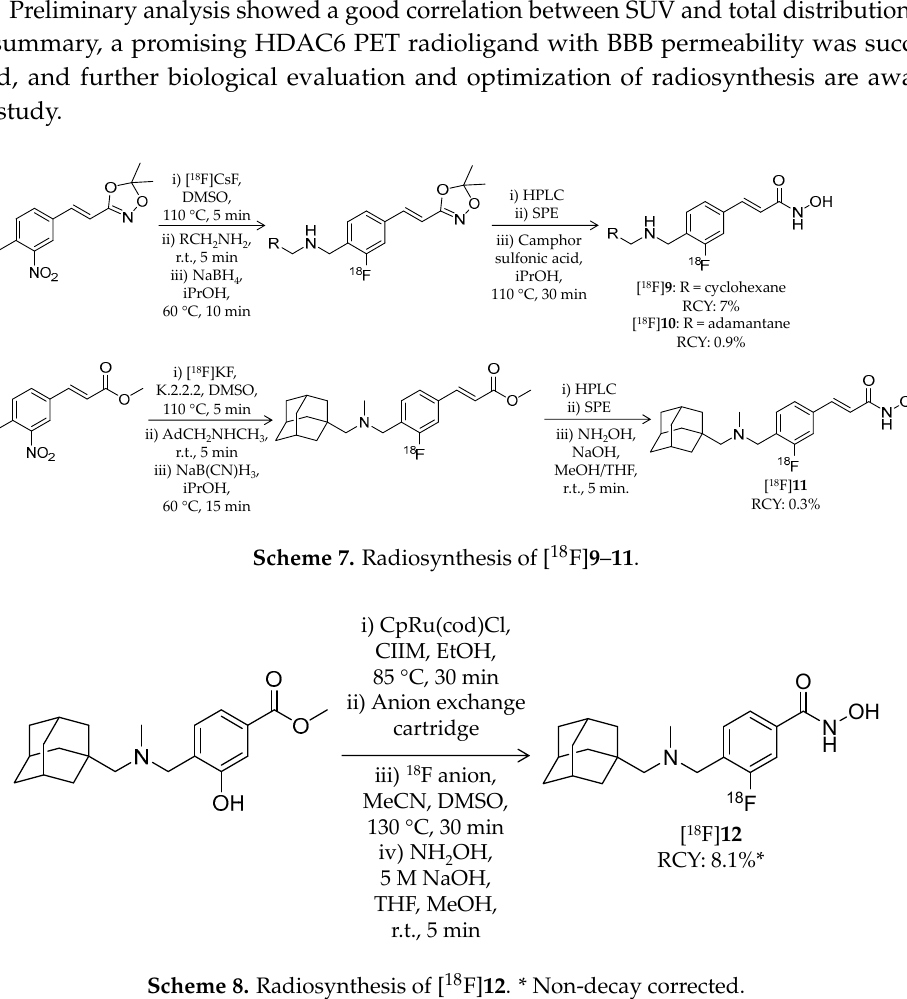
Figure 3. The total volume of distribution ( V T ) images from [ 11 C] 8 PET in baboon brains. Robust brain uptake ( top ) of [ 11 C] 8 was decreased by pre-treatment with unlabeled 8 ( bottom ). (Reproduced from Wang et al. J Med Chem; published by The American Chemical Society, 2014 [68]). HPLC purification gave the desired product in 0.3% decay-corrected radiochemical yield. All three compounds showed high affinity for HDAC1, 2, 3, and 6 (IC 50 values: <20 nM). Brain kinetics